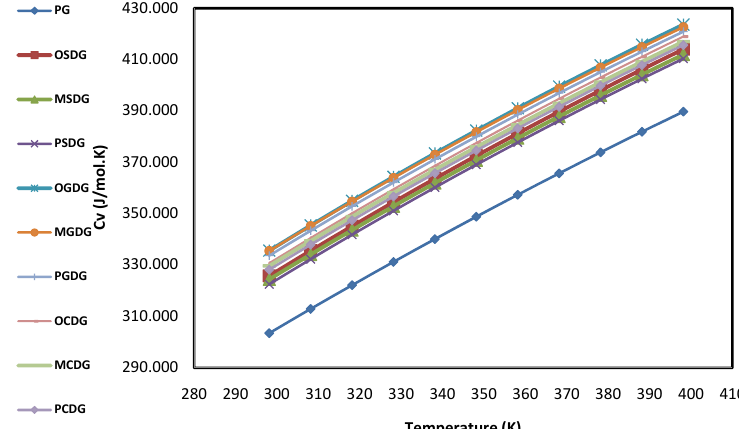
Fig. 4. The specific heat capacity of the nano-adsorbents in the temperature range of 298.15 to 398.15 K at 10º intervals. Table 6. Calculated E H and E L , HLG, chemical hardness ( ), electrophilicity index (ω), and the maximum amount of electronic charge index, ΔN max and dipole moment for the silver adsorption